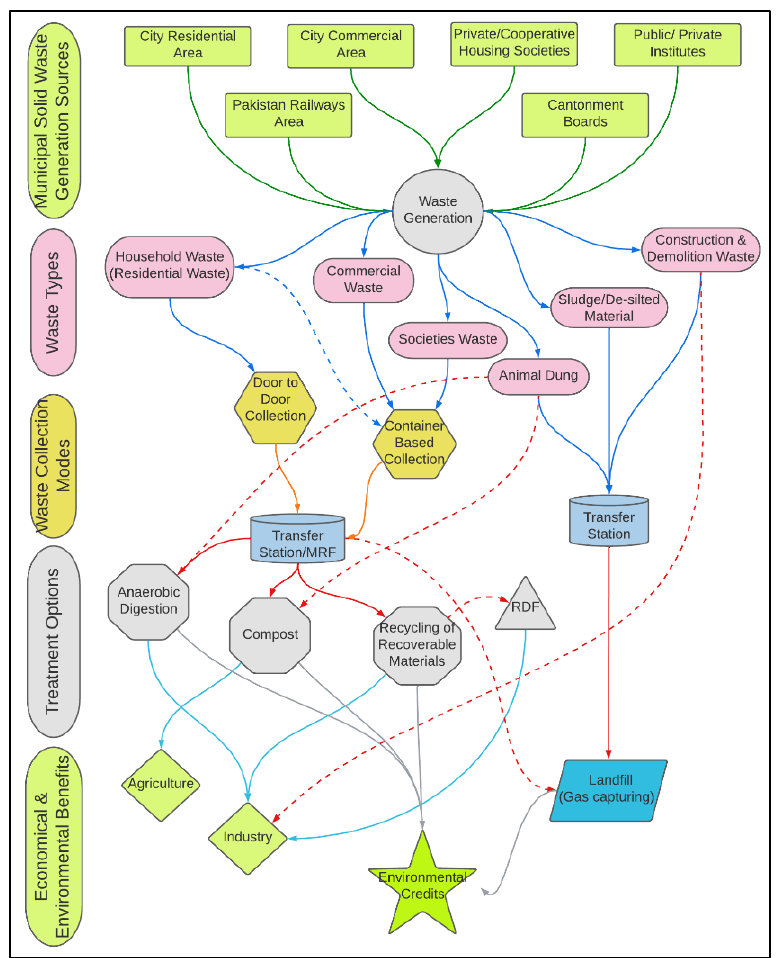
Figure 22. Proposed waste management model for Lahore.